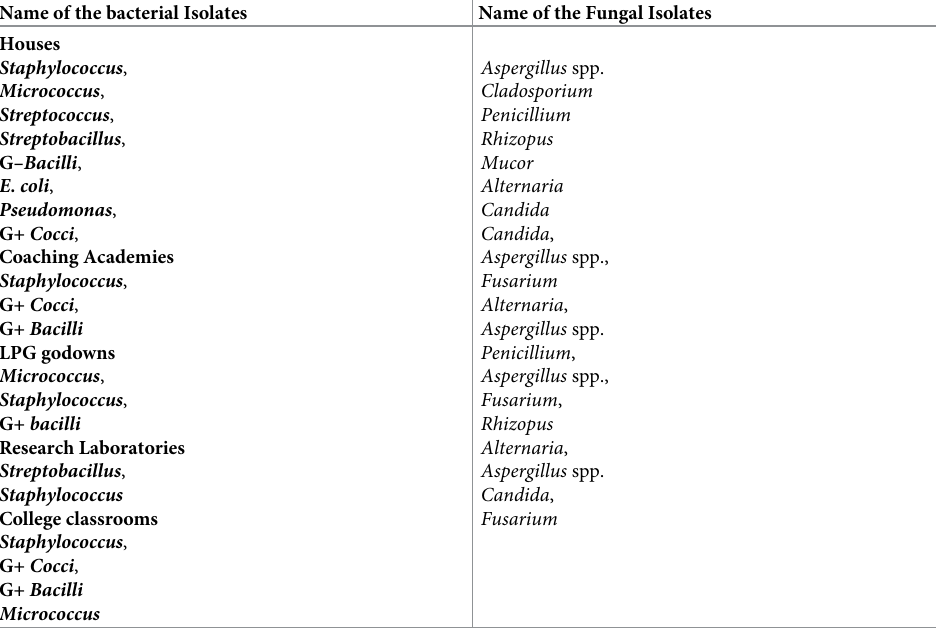
Table 3. Major fungal and bacterial isolated in different